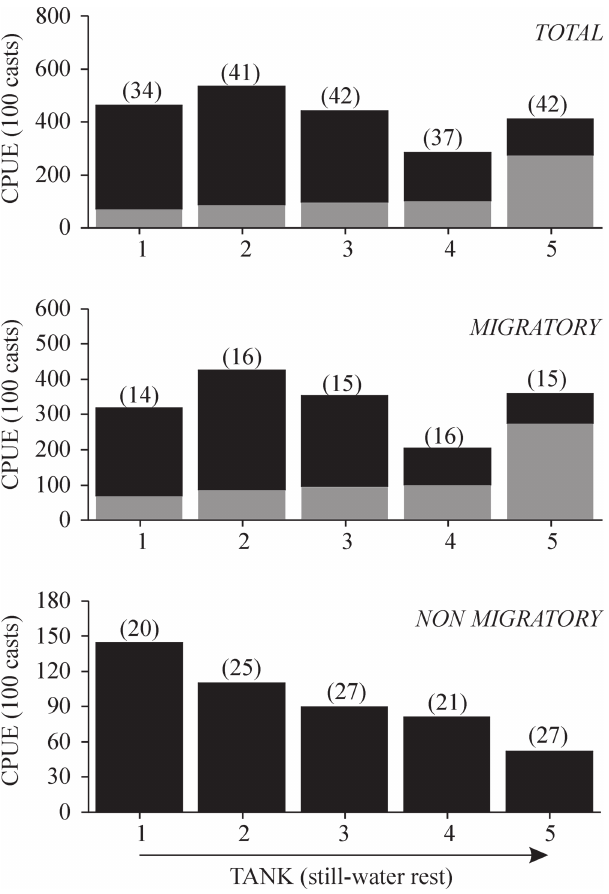
Fig. 3. Monthly occurrence (a) and catch per unit effort (CPUE; individuals per 100 casts) (b) of the four most abundant spe- cies in the fish ladder at Lajeado Dam (arrow indicates up-